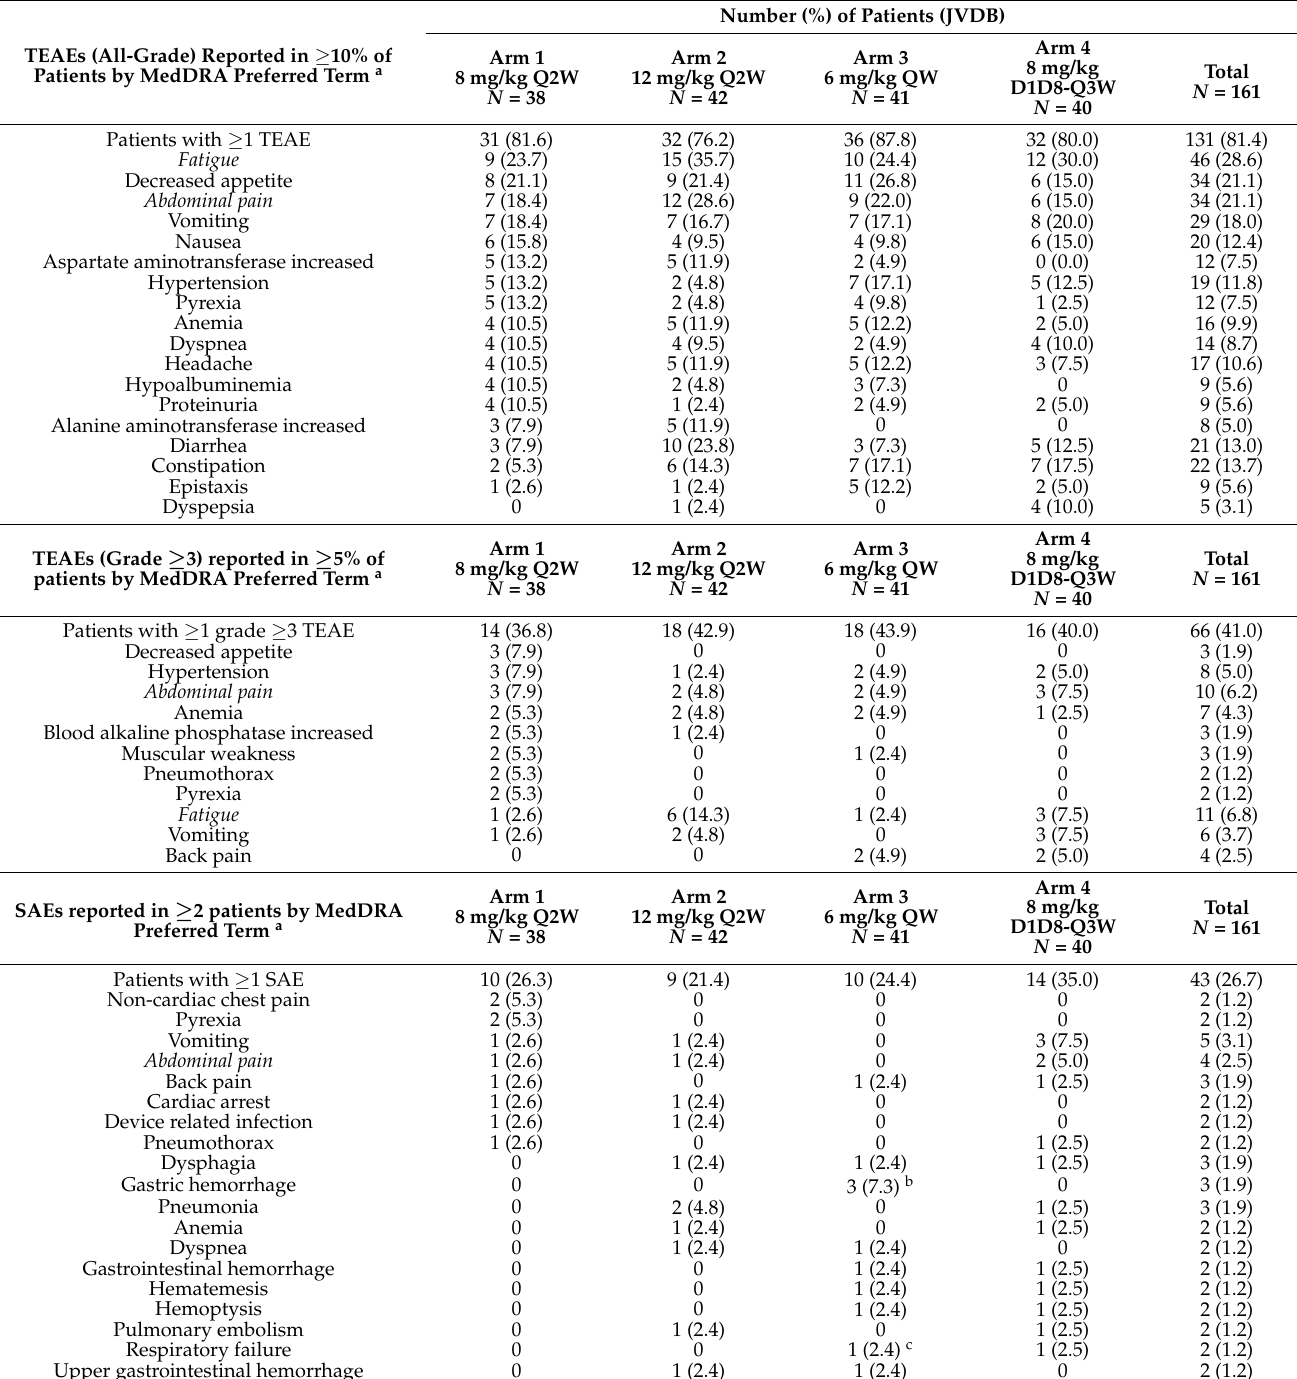
Table 1. Study JVDB: treatment-emergent adverse events and serious adverse